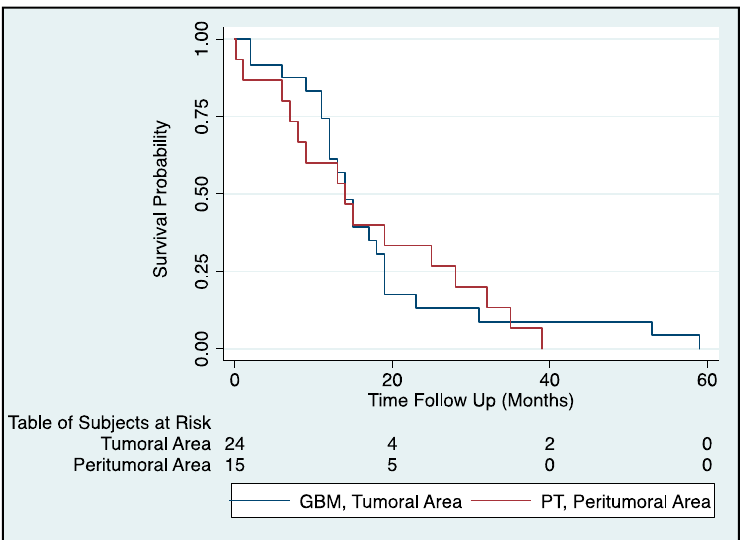
Figure 5. Survival of GBM patients is inversely correlated to MGMT expression in the PT area: The Kaplan–Meier plot depicts the differences in survival when patients with a percentage of MGMT- positive cells >50% were stratified based on the tissue areas (GBM, tumoral area; PT, peritumoral area). Furthermore, the number of surviving subjects per time unit is described in Table of Subjects at Risk. According to the Cox model (proportional hazard, Cox regression: Breslow method for ties), survival decreases significantly for patients showing >50% of MGMT-positive cells in the PT area ( p < 0.05 log-rank test; z = − 2.12; 95% CI = 0.026–0.00095). Table 1. Clinicopathological characteristics of 55 patients with primary GBM